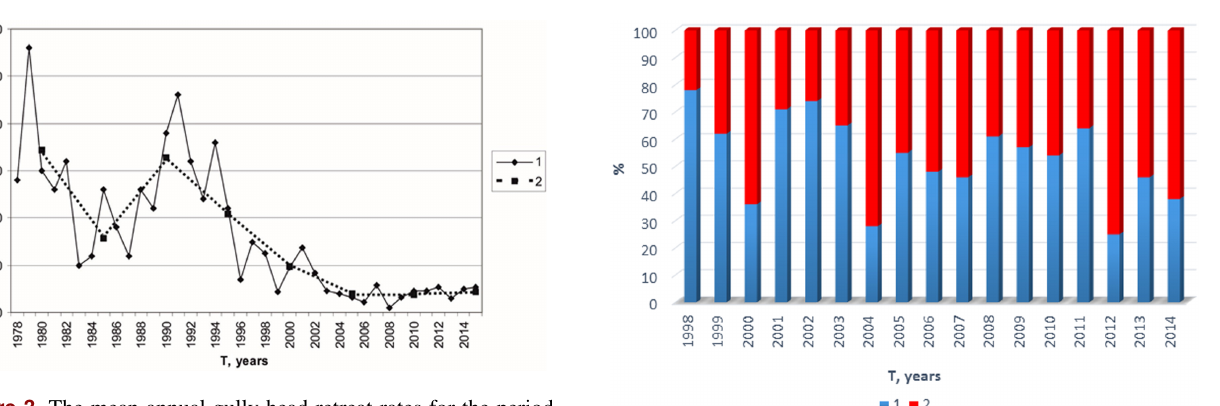
Figure 3. The mean annual gully head retreat rates for the period 1978–2015, based on results of the field monitoring of gully heads at 28 sites (for site location see Fig. 1) (Legend: 1 – mean annual rates; 2 – mean rate for five-year periods).